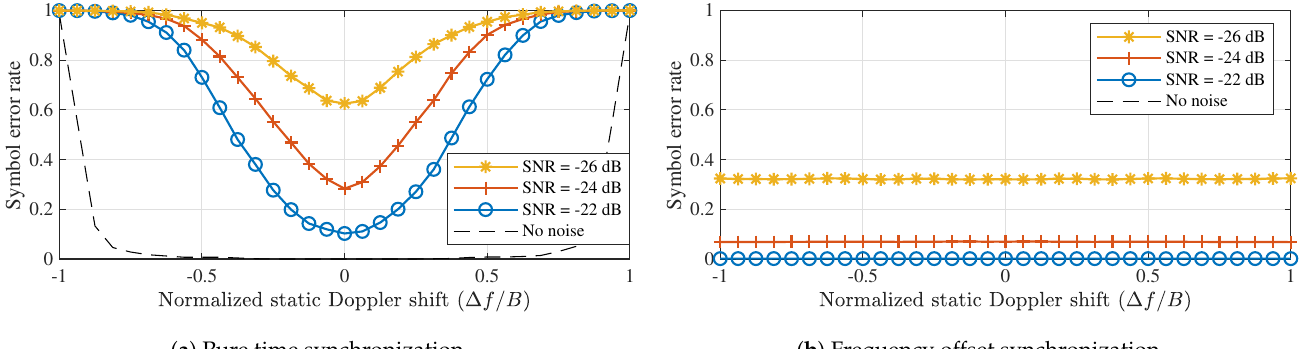
Figure 5. LoRa symbol detection performance when using the different synchronization strategies illustrated in Figure 4. Both strategies are presented with the value for the frequency shift applied to the synthesized symbol. ∆ n is calculated based on this metric. (SF = 12, B =